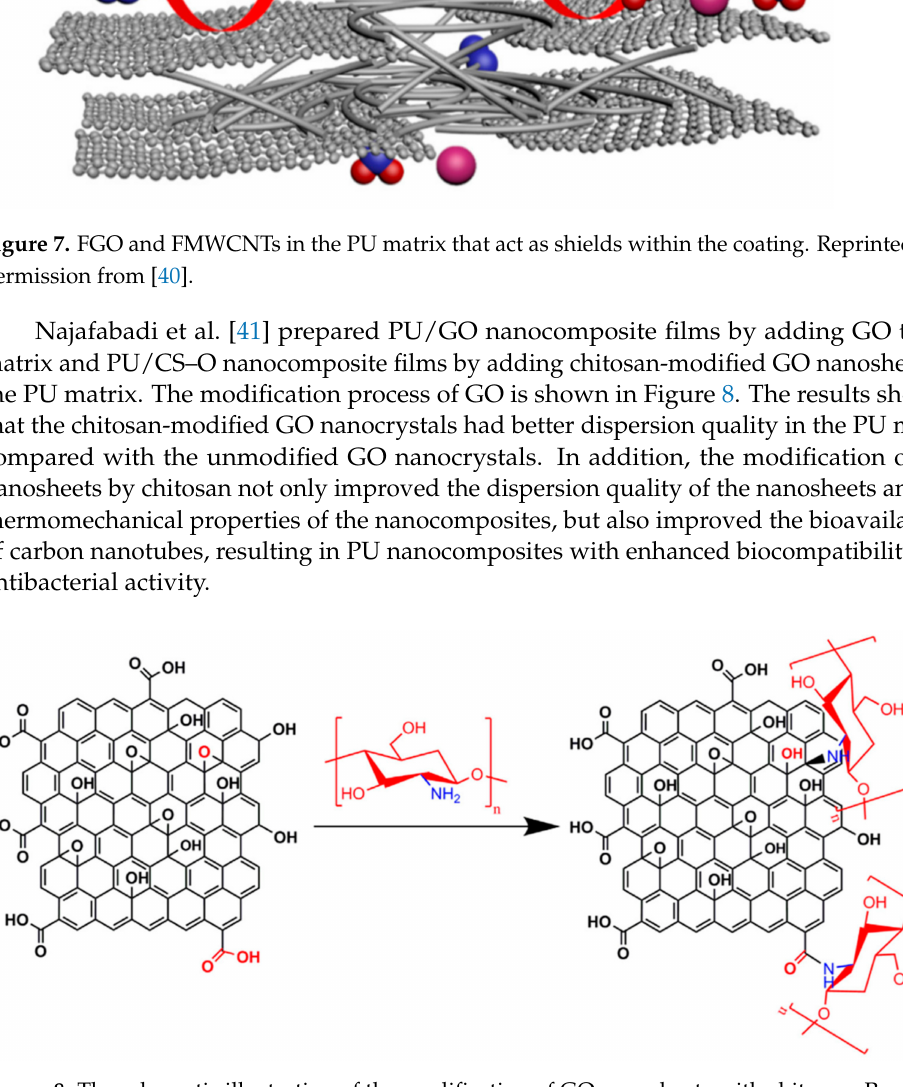
Figure 8. The schematic illustration of the modification of GO nanosheets with chitosan. Reprinted with permission from